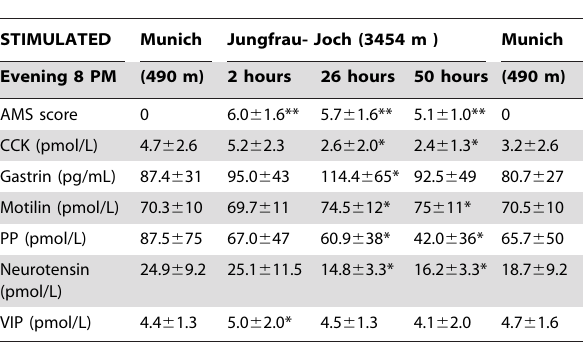
Table 2. Influence of rapid exposure of 11 subjects to high altitude on stimulated plasma concentrations of gastroentero- pancreatic peptides and on acute mountain sickness (AMS) score at 8